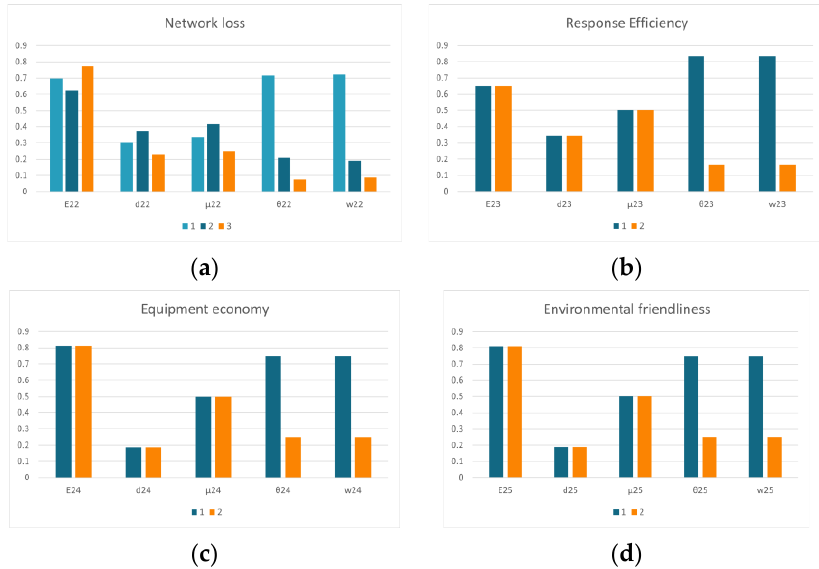
Figure 7. Calculation results of secondary indicators. ( a ) Network loss. ( b ) Response efficiency. ( c ) Equipment economy. ( d ) Environmental friendliness.